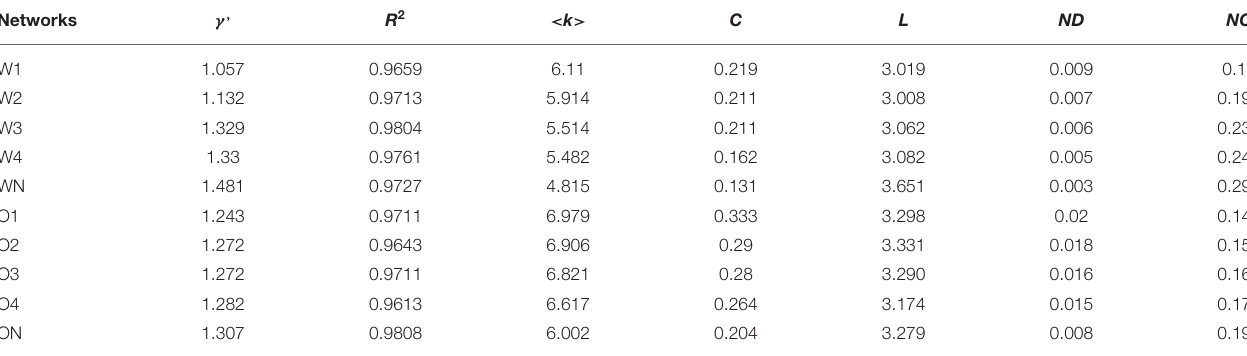
TABLE 4 | Major parameters of the 10